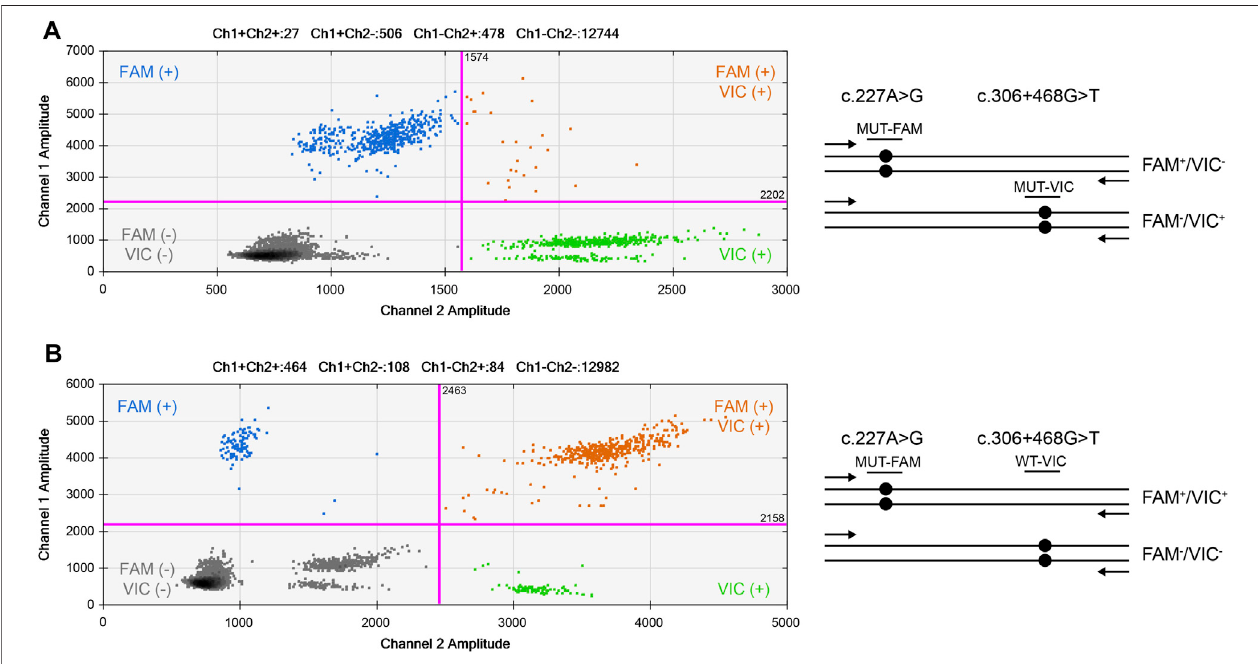
FIGURE5| 2Dclusterplotofdroplet fl uorescenceforthe denovo locusandreferencelocus. (A) Theresultofc.306+468G > Tmutantandc.227A > Gmutantprobes. (B) The resultofc.306+468G > Twild-typeandc.227A > Gmutantprobes.FAM ™ positive(Channel1,mt − )dropletsformthetop-leftbluecluster,HEX ™ positive(Channel2,mt+)droplets form the bottom-right green cluster, negative droplets for both targets form the bottom-left gray cluster, and positive droplets for both targets form the top-right orange cluster.